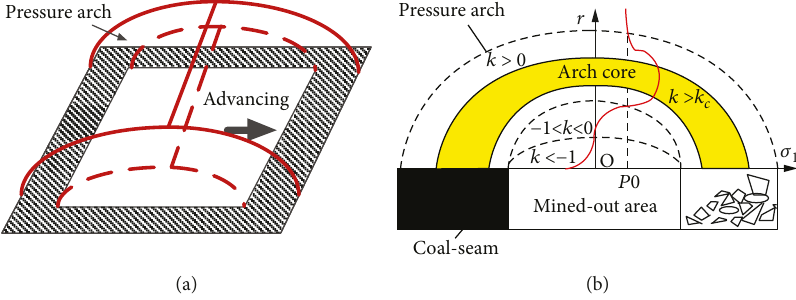
Figure 4: The pressure arch in the surrounding rock. (a) Engineering model. (b) Mechanical